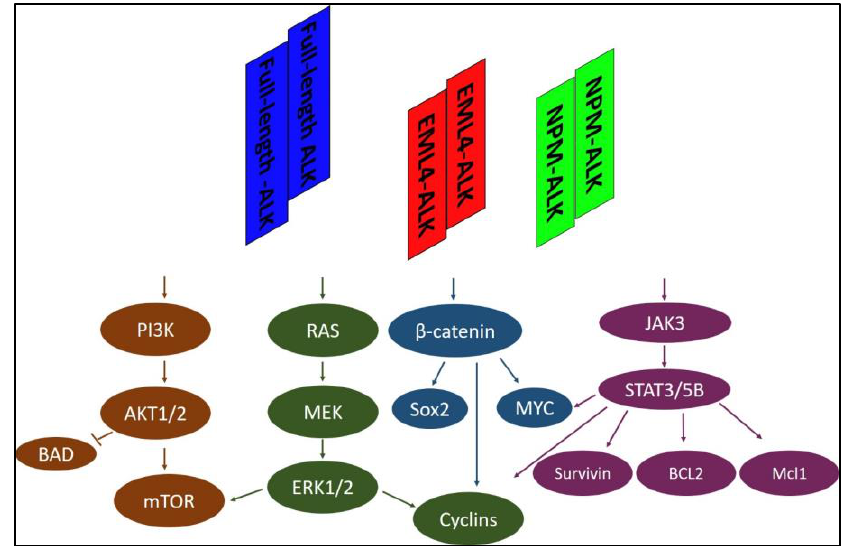
Figure 1. Representative signaling pathways activated by full-length ALK, EML4-ALK, or NPM-ALK. The ALK protein interacts and activates many essential adaptors involved in multiple signaling pathways, including PI3K, RAS/MEK/ERK, β-catenin, and JAK/STATs. Only four representative signaling pathways are shown here. EML4-ALK: echinoderm microtubule-associated protein like 4-anaplastic lymphoma kinase; NPM-ALK: Nucleophosmin-anaplastic lymphoma kinase; STAT: Signal transducer and activator of transcription; PI3K: phosphatidylinositol 3 kinase; ERK: extracellular signal-related kinase; JAK3: Janus kinase 3; Bcl2: B-cell lymphoma 2; Mcl1: Myeloid cell lymphoma 1; BAD: Bcl-2-associated death promoter; mTOR: mammalian target of rapamycin; MEK: MAPK (Mitogen-activated protein kinase)/ERK (extracellular signal-regulated kinase); Sox2: (sex determining region Y)-box 2.